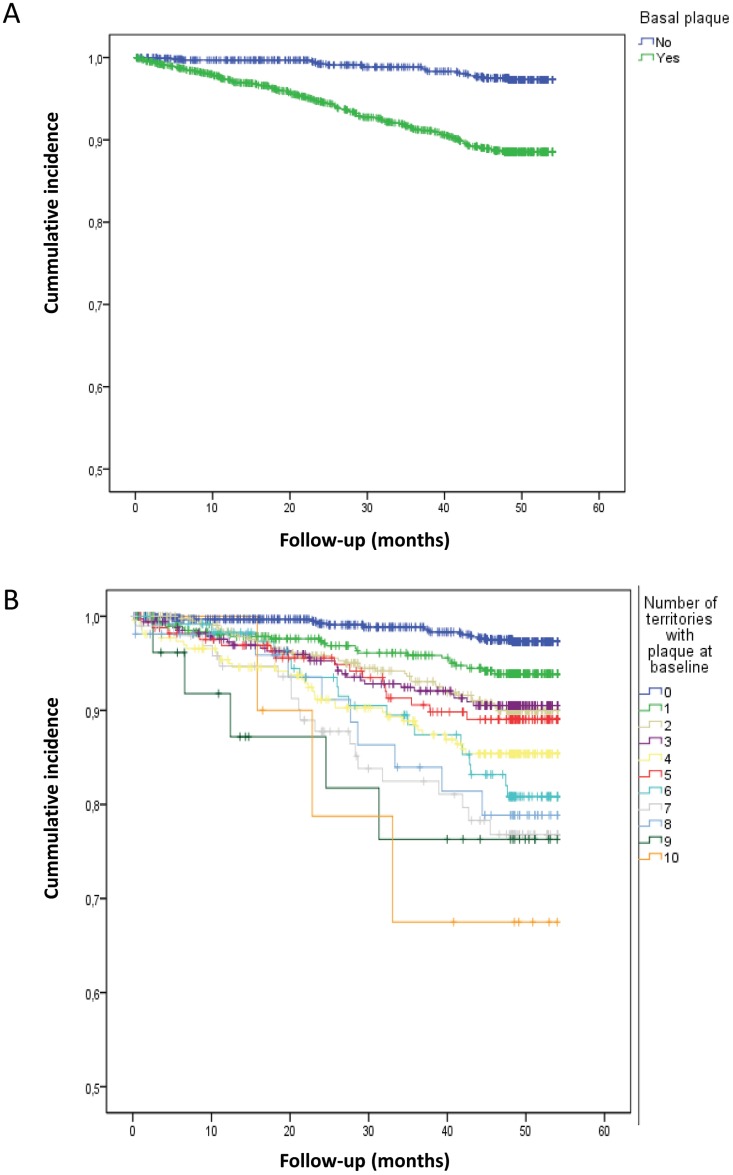
Kaplan-Meier curve showing the unadjusted incidence of CVE along the follow up time (months) depending on (A) the presence or absence of atheroma plaque (p<0.000 Mantel-Haenzel) or (B) the number of arterial territories with atheroma plaque (p<0.000 Mantel-Haenzel linear trend).